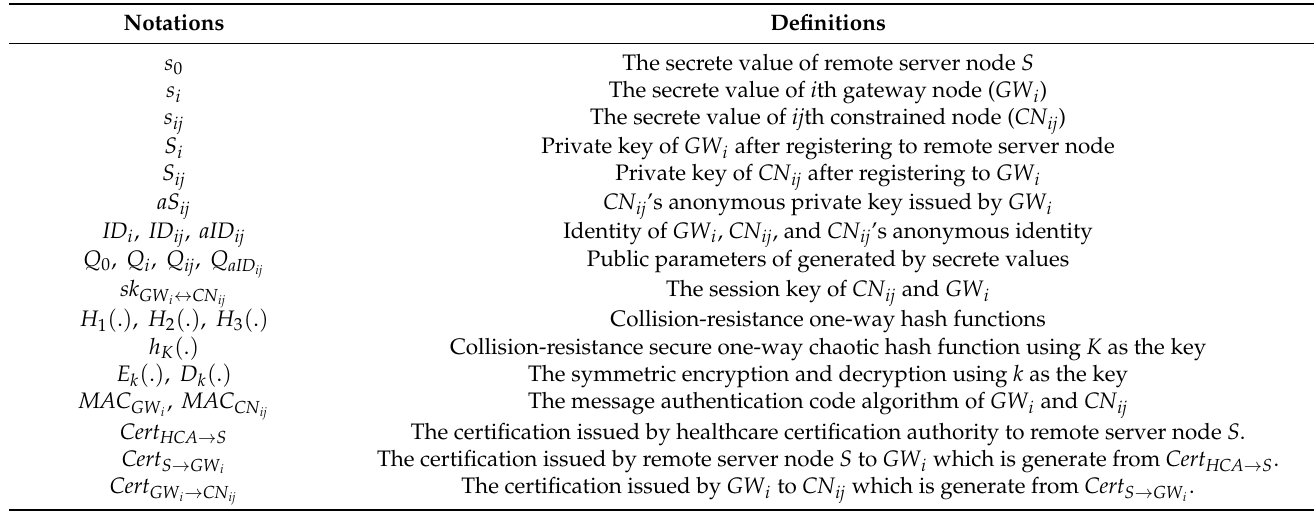
Table 1. Notations of the proposed